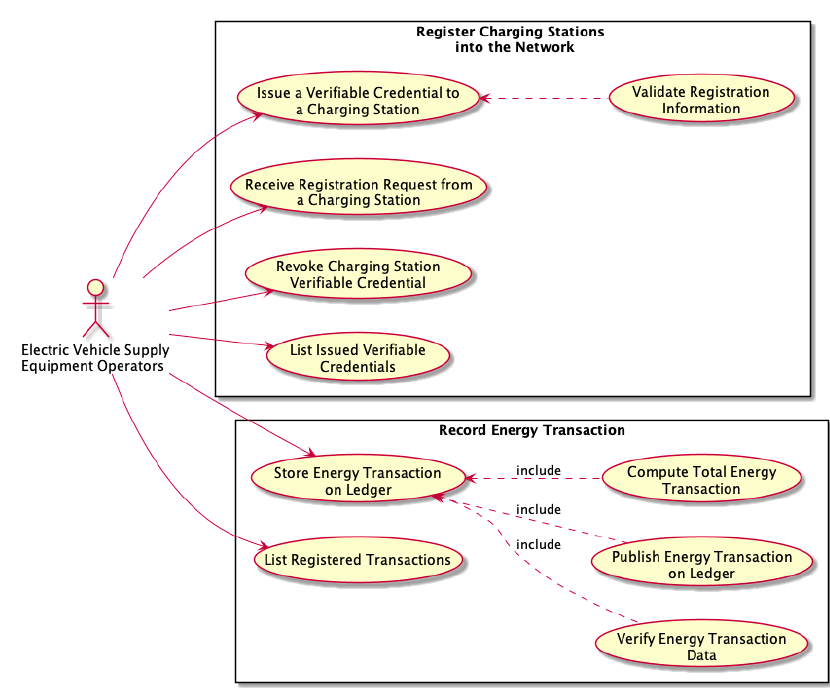
Figure 20. Use cases implemented by the EVSEO.